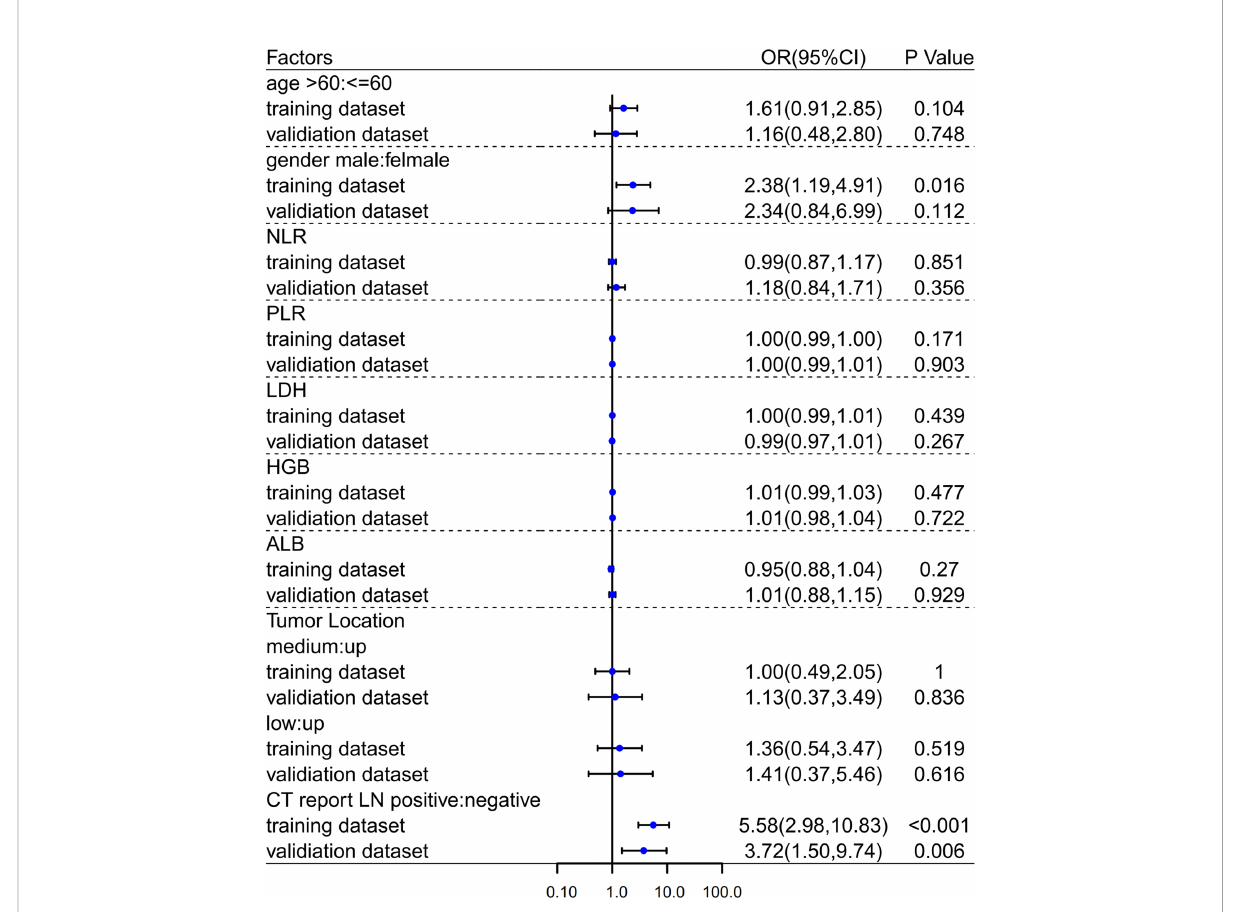
FIGURE 3 Univariate analyses in training and validation dataset. OR, Odds Ratio; 95%CI, 95% con fi dence